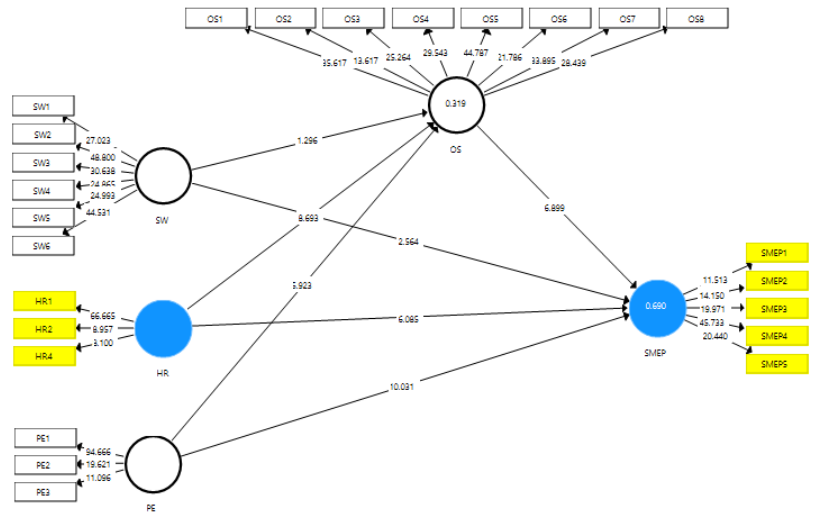
Fig. 4. Structural Model